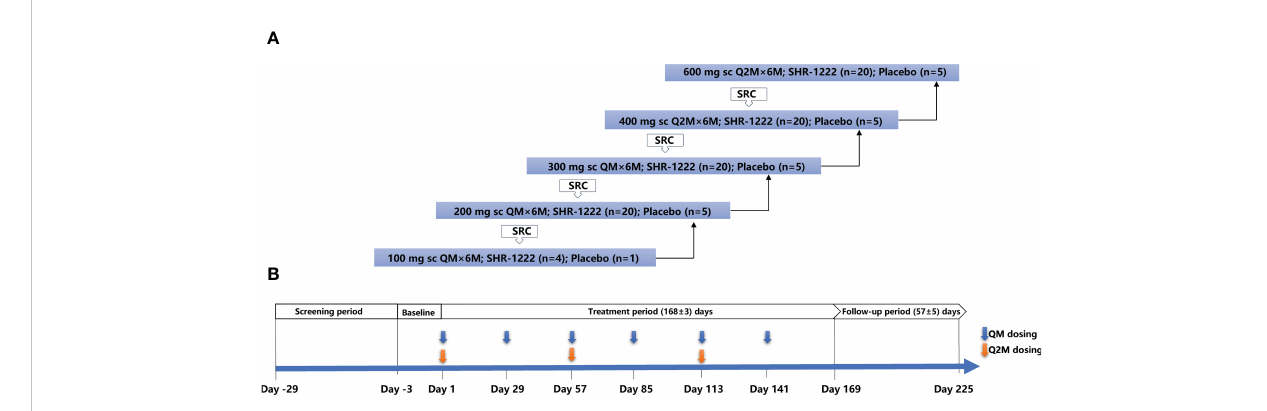
FIGURE 1 Study design. (A) Framework for the dose-escalation of SHR-1222. (B) Dosing and assessment schema. QM, once every month; Q2M, once every 2 months; SRC, safety review